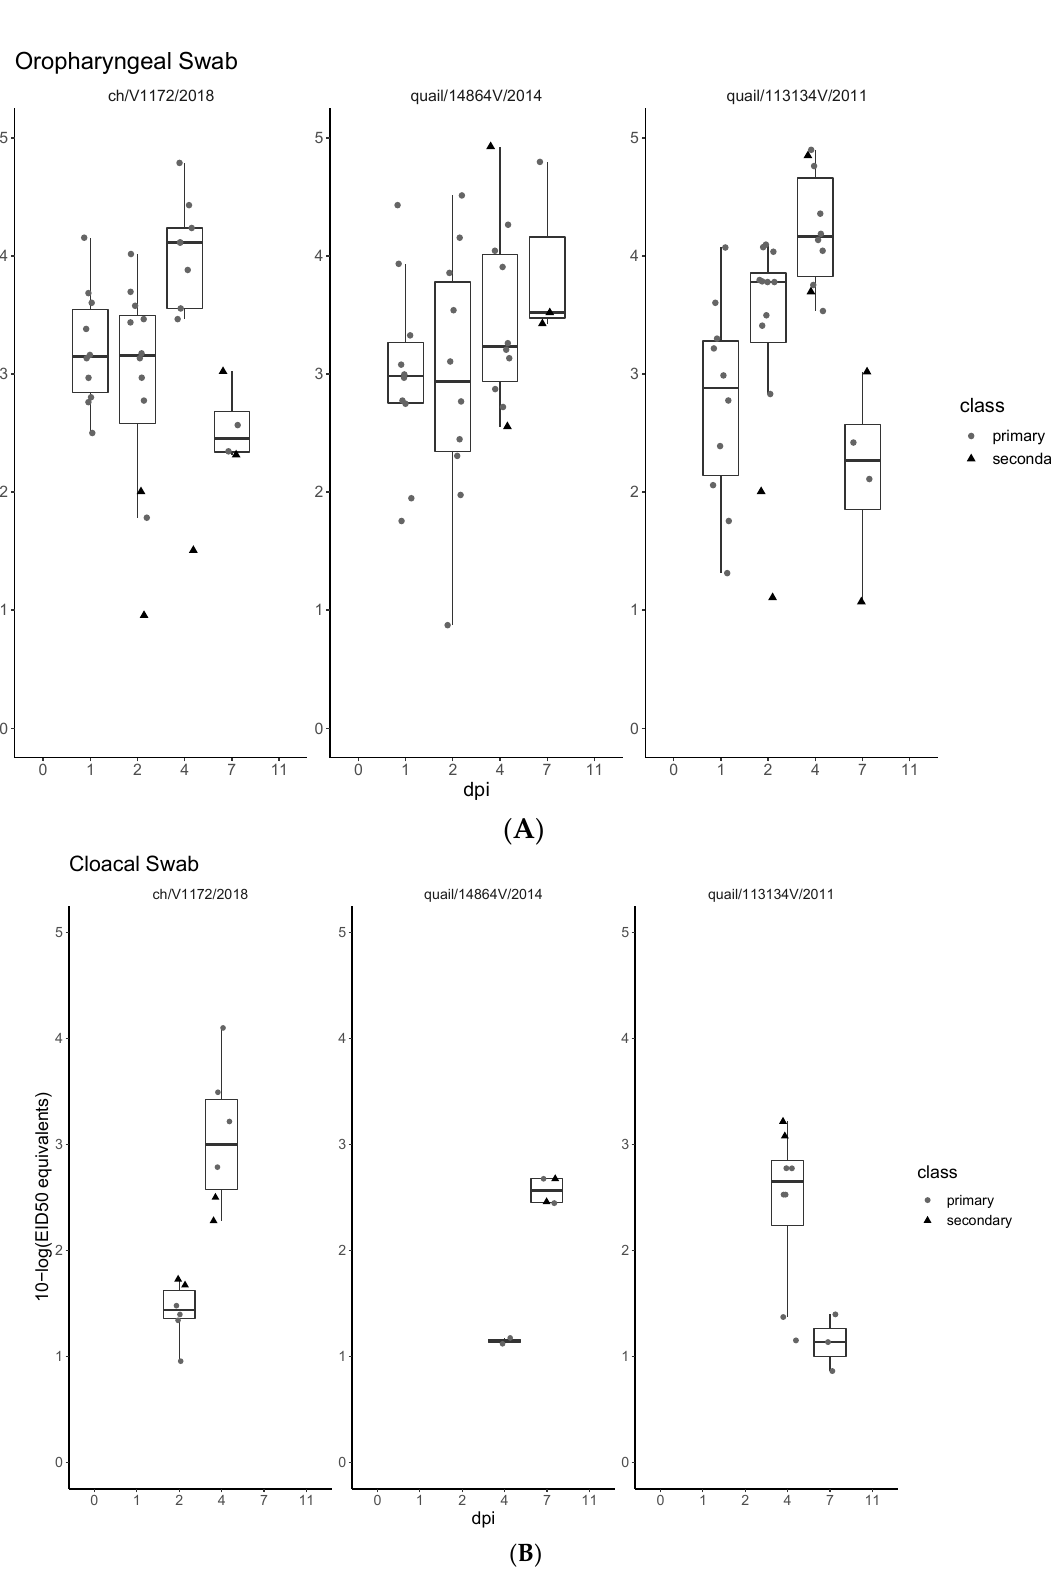
Figure 3. Virus shedding of LPAIV H9N2 infected chickens. Oropharyngeal ( A ) and cloacal ( B ) swabs were sampled at indicated days post-infection (dpi) and tested by RT-qPCR. Individual results of detected RNA copy numbers are given as EID 50 equivalents. Circle indicates primary chicken and triangle indicates secondary/contact chickens.